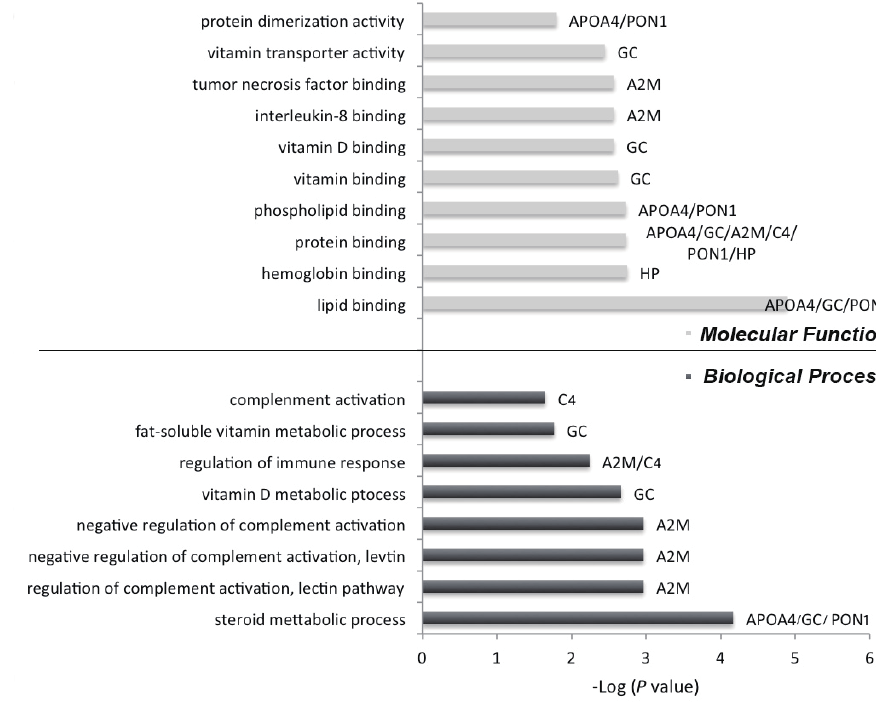
Figure 3. Gene ontology analysis. The abscissa was the –Log (p value) to shown the significance between proteins and annotation. The ordinate was the annotation of molecular function (above) and biological process (below). Protein abbreviations are included in the bar graph. APOA4, apolipoprotein A-IV; PON1, Paraoxonase 1; GC, vitamin D-binding protein; A2M, A2M protein; C4, complement C4; HP,